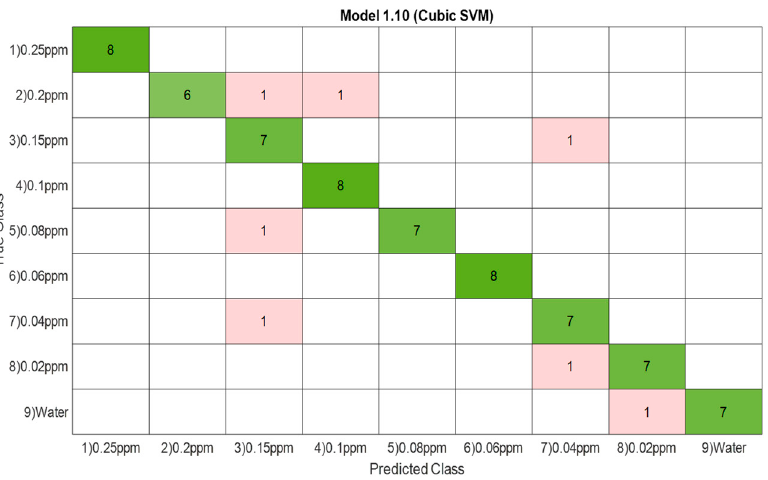
Figure 16. Confusion matrix for the SVM model with cubic kernel for classifying the pesticide Numetrin at different concentrations against distilled water samples.